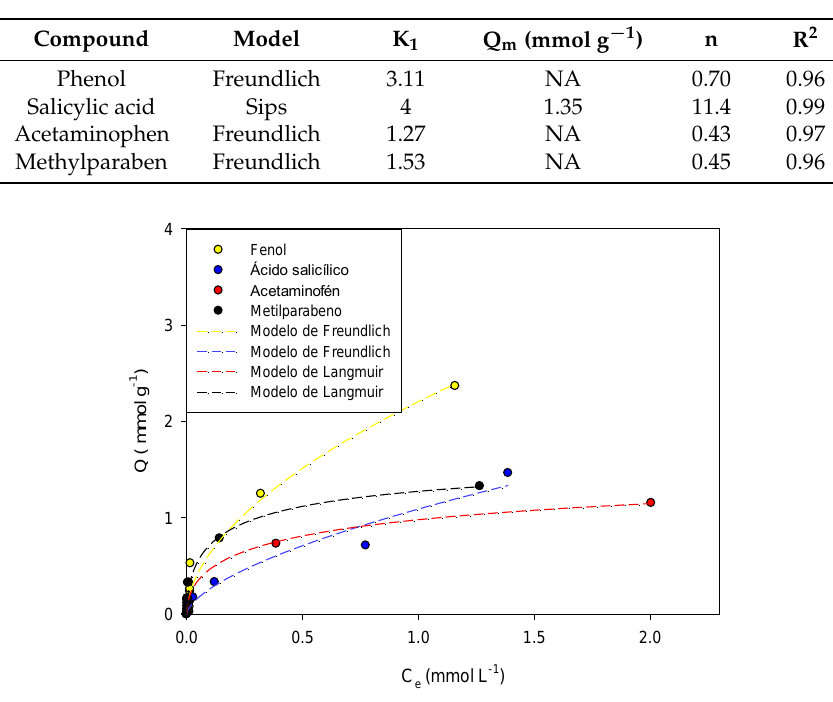
Figure 7. Adsorption isotherm of phenol, acetaminophen, salicylic acid, and methylparaben on activated carbon CAR1273 at 293 K. Table 12. Parameters of Langmuir and Freundlich models for phenol, acetaminophen, salicylic acid, and methylparaben adsorption on activated carbon CAR1273.